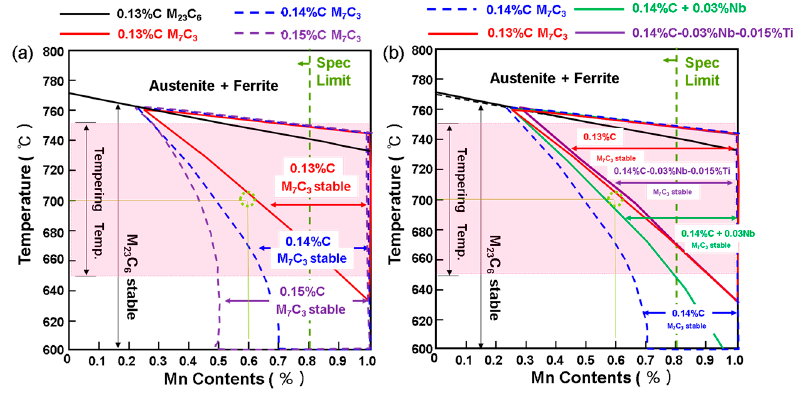
Figure 9. Phase diagrams calculated by Thermo-Calc: ( a ) comparison of the effects of the addition of 0.15–0.13% C and 0–1.0% Mn; ( b ) comparison of the effects of the addition of 0.14–0.13% C, 0–1.0% Mn, 0.03% Nb, and 0.015% Ti.